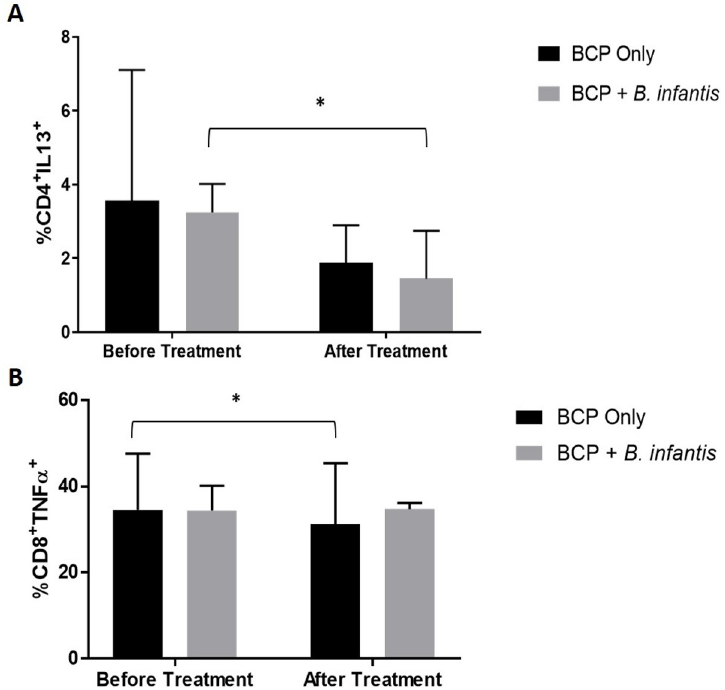
Fig 10. Changes in cellular cytokine production with treatment. Median and interquartile range of percentage of stimulated lymphocytes expressing intracellular cytokines before and after treatment (n = 7 per group). (A) Percentage of stimulated CD4 + cells producing intracellular IL-13, and (B) percentage of stimulated CD8 + cells producing TNF- α , before and after treatment. Significant differences in percentage before and after treatment (p < 0.05) are denoted by an